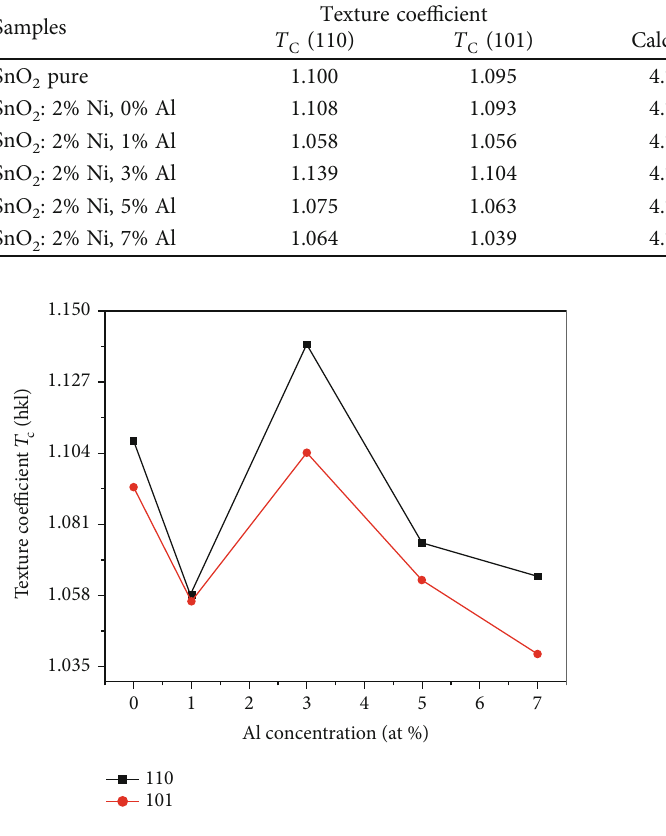
Figure 5: Transmission spectrum of Al-Ni-codoped SnO fi lms with Ni = 2 at. % and di ff erent Al concentrations (0%, 1%, 3%, 5%, and